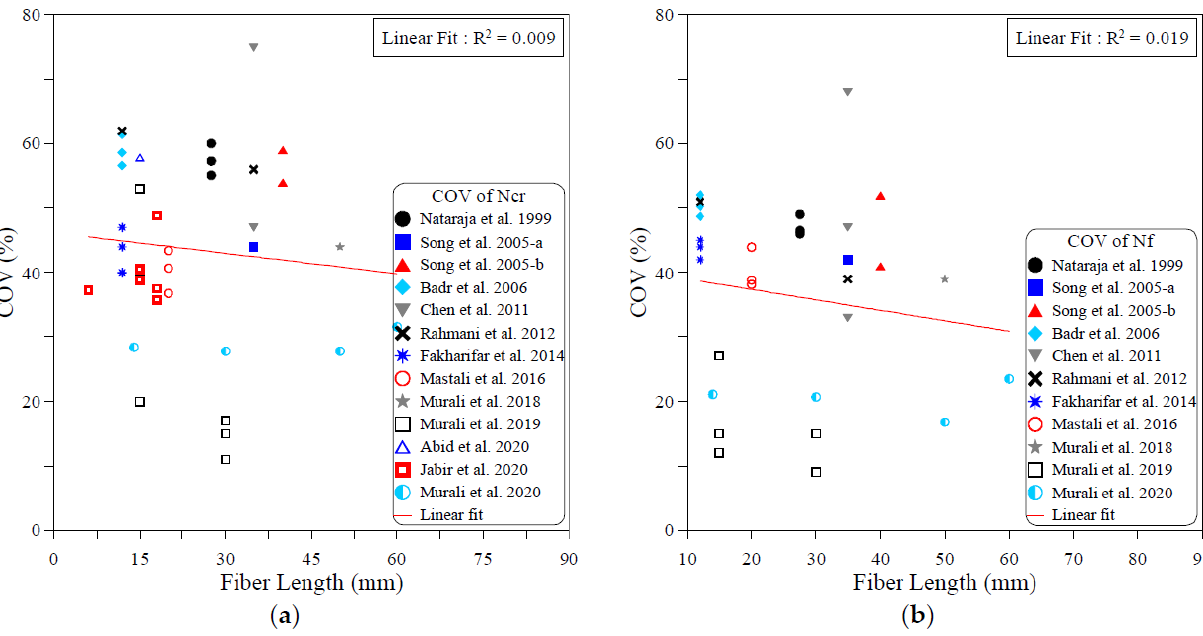
Figure 7. Effect of fiber length on the scattering of impact results at ( a ) cracking and ( b ) failure.